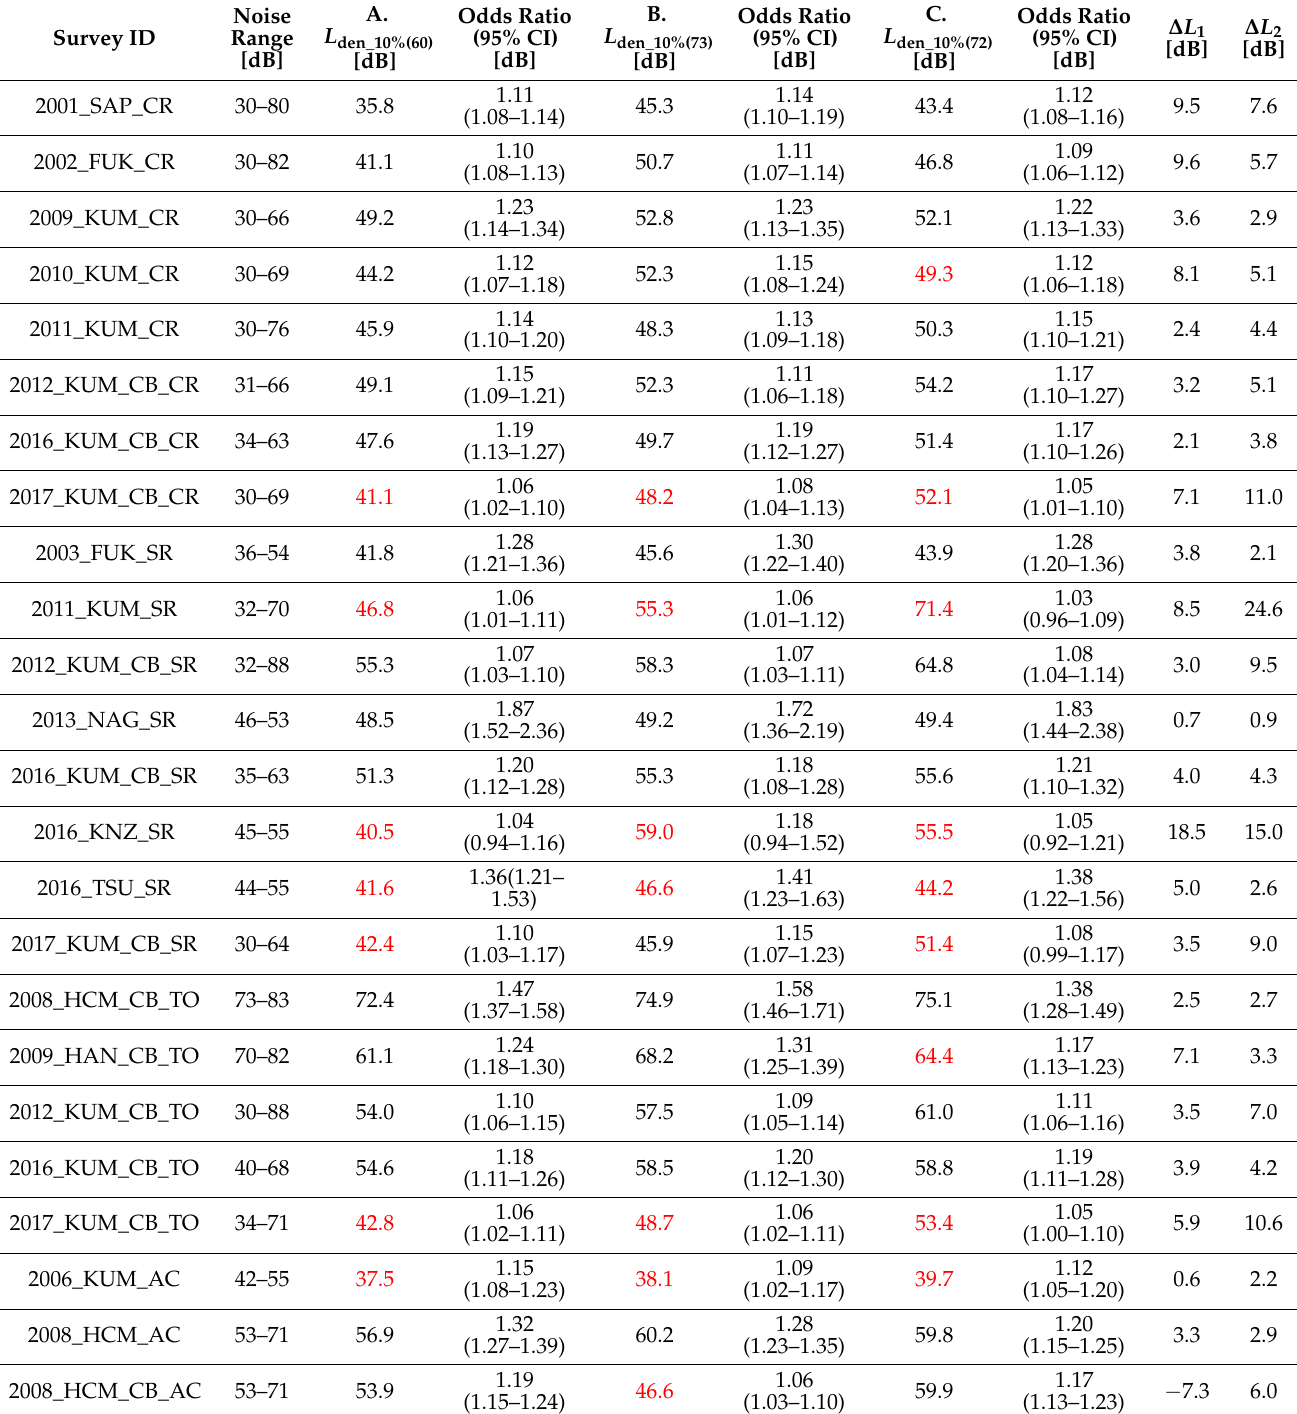
Table 2. L den values at 10% HA for 60%, 73%, and 72% cutoffs of HA, ∆ L 1 , and ∆ L 2 . “CB” in the “Survey ID” column indicates the combined noise survey. For example, “CB_CR” indicates data of conventional railway noise in the combined noise survey. The odds ratio for L den in each dataset analysis is also shown with the 95% confidential interval (CI). Numbers in red indicate that the AUC values of the logistic regression model are below